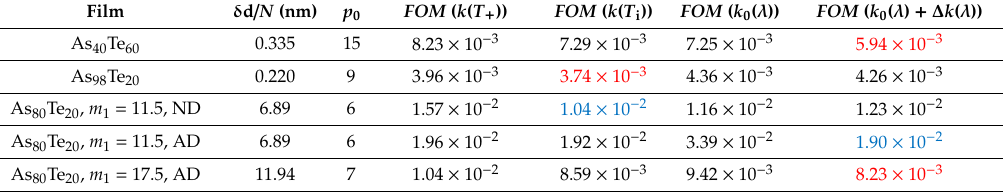
Table 2. Supplementary data about the characterizations of the As x Te 100 − x films based on the AOEM, as p 0 is the optimized degree of the polynomial representing n ( λ ) according to Equation (6). The lowest FOM for a given film is in red color and the lowest FOM for each of the other characterizations of the As 80 Te 20 film is in blue. The selected extinction coe ffi cient k ( λ ) of each of the three films corresponds to the FOM value in red